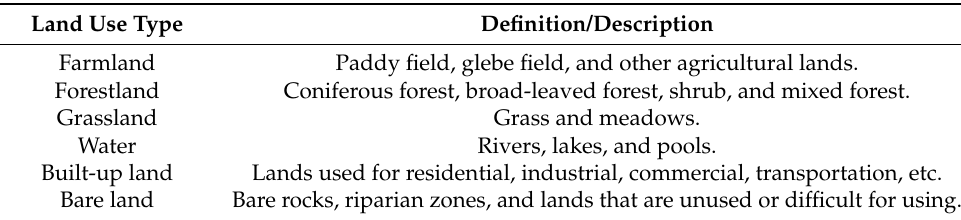
Table 1. Categories and definitions of land use types in Wuhan city,